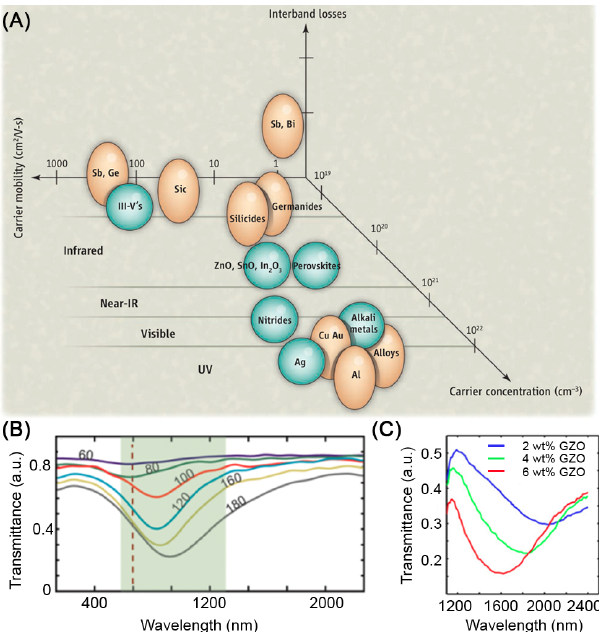
Figure 7: (A) Distribution of alternative materials over the electro- magnetic spectrum where metals cover UV-visible range, plasmonic metal nitrides cover visible-near infrared and semiconductors cover longer wavelengths in the near infrared. (B) Transmittance data obtained from titanium nitride (TiN) nanodisks with varying diam- eter where extinction dip due to plasmonic resonance covers the biological transmittance window. (C) Transmittance data from gal- lium doped zinc oxide (GZO) nanodisks with resonance around the telecommunication wavelengths. Figures (A,B,C) adapted with permission from references [139-141], respectively. (A): Copyright (2011) AAAS. (B) Copyright (2013) American Chemical Society. (C): Copyright (2013)